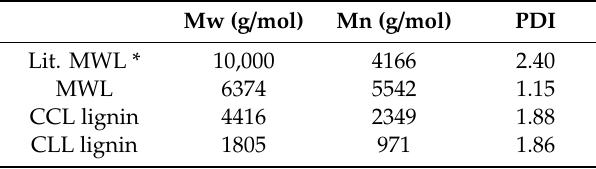
Table 4. Average molecular weights and polydispersity indices of MWL and DES lignin. Mw (g / mol) Mn (g /